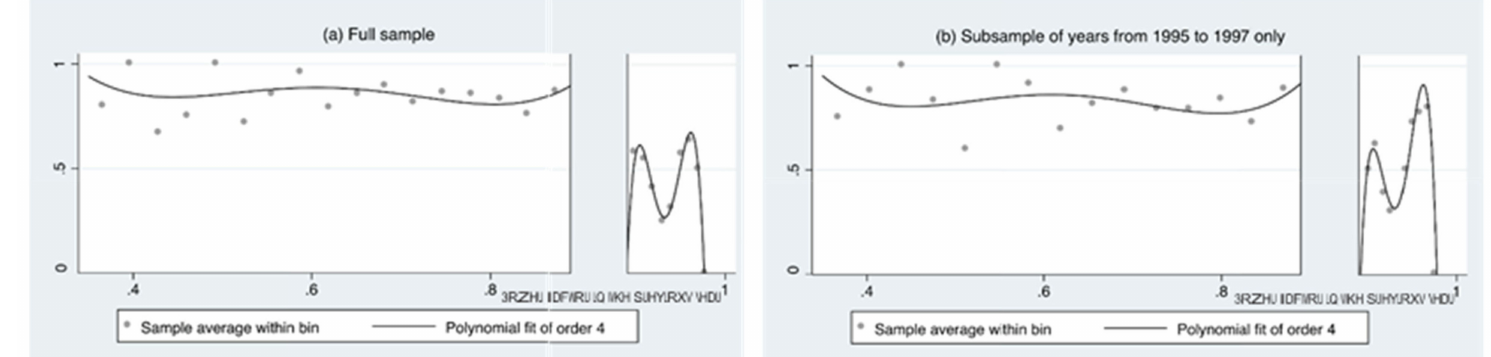
Figure 2. Probability of power factor improvement and its discontinuity at the penalty threshold. The probability of power factor improvement is on the vertical axis, and the level of the power factor in the previous year is on the horizontal axis. The cuto ff is shown as a vertical line at 0.895 of the horizontal axis. The number of observations used in panel ( a ) is 732, of which 454 are on the left and 278 are on the right of the cuto ff . The number of observations used in panel ( b ) is 549, of which 366 are on the left and 183 are on the right of the cuto ff